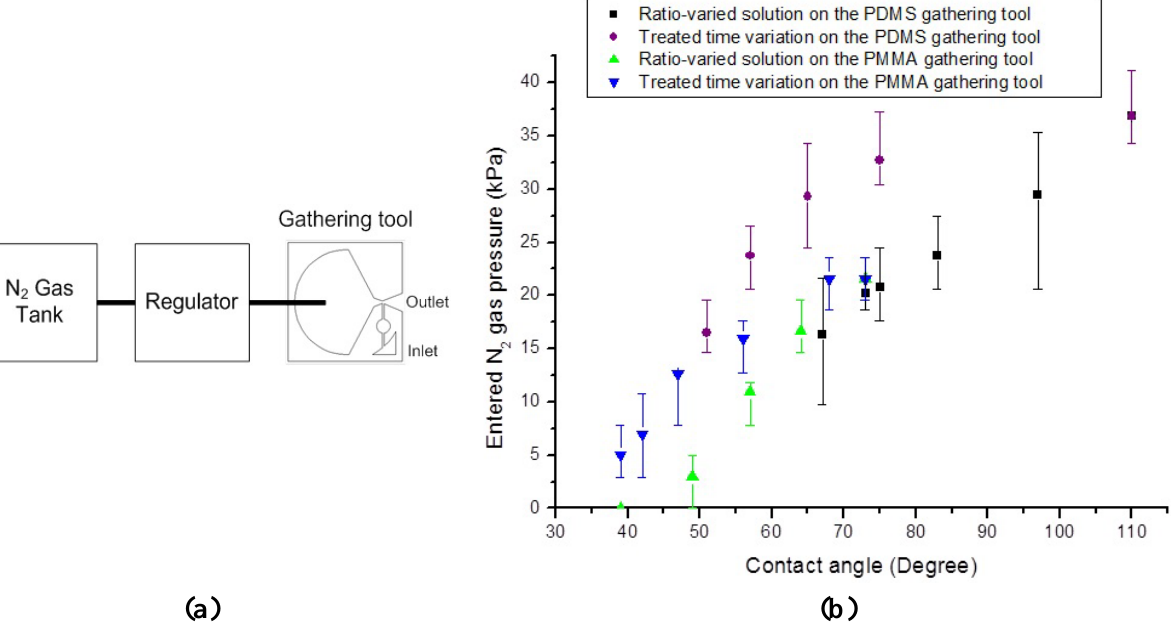
Figure 9. (a) The conceptual schematic of the minimum N setup. (b) The graph of the minimum N